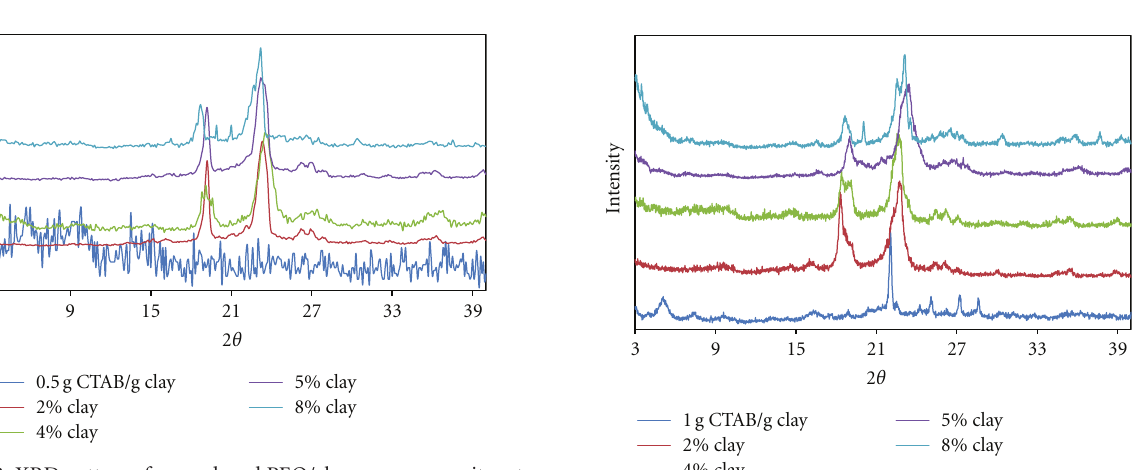
Figure 3: XRD patterns for produced PEO/clay nanocomposites at various clay compositions (0.5g CTAB/g clay ratio).